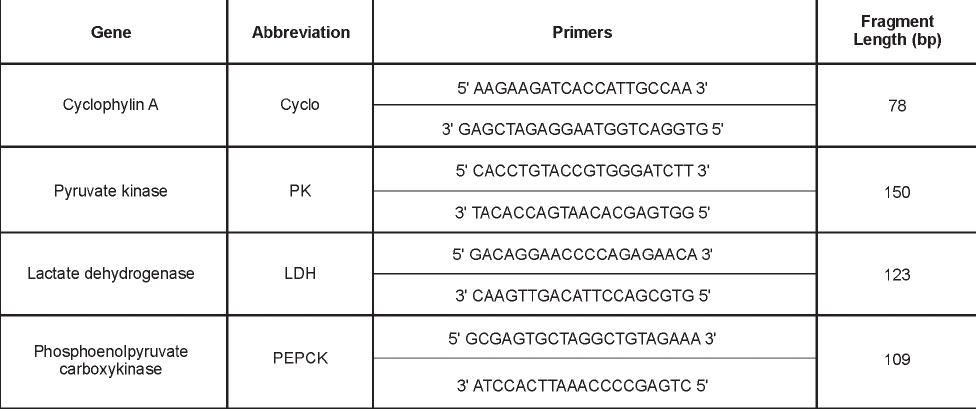
Figure 2 – List of primers sequences. Cyclophylin A, Piruvate kinase, Lactate dehydrogenase and Phosphoenolpyruate carboxykinase.